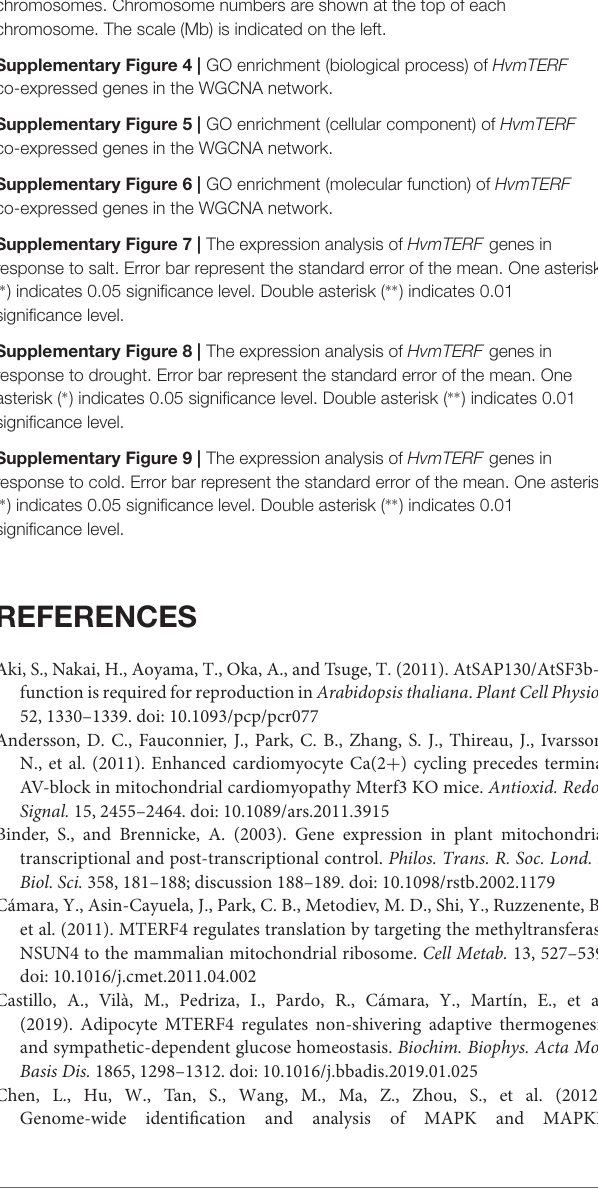
Supplementary Figure 10 | The expression analysis of HvmTERF genes in response to ABA. Error bar represent the standard error of the mean. One asterisk ( ∗ ) indicates 0.05 significance level. Double asterisk ( ∗∗ ) indicates 0.01 significance level. Supplementary Figure 11 | Nucleotide diversity of wild barley and landraces accessions. The horizontal line inside the box corresponds to the median of this distribution, the bottom and top of the box are the first and third quartiles and data points outside the whiskers can be considered as outliers. The nucleotide diversity was calculated based on HvmTERF -related SNPs. Supplementary Table 1 | Accession number and samples information of RNA-seq data used in this study. Supplementary Table 2 | The primers used in the qRT-PCR. Supplementary Table 3 | Summary information of the 220 wild barley accessions and landraces. Supplementary Table 4 | Characteristic features of mTERF gene family in barley. Supplementary Table 5 | Verification of the mTERF domains using the NCBI-CDD, SMART, HMMER, and InterPro online tools. Supplementary Table 6 | Consensus motifs analysis of mTERF domains in different species. Supplementary Table 7 | The segmental and tandem duplication events of HvmTERF s. Supplementary Table 8 | The Ka/Ks ratios and estimated divergence time between barley and other five species ( A. thaliana , B. distachyon , O. sativa , Vitis vinifera , Zea mays ).